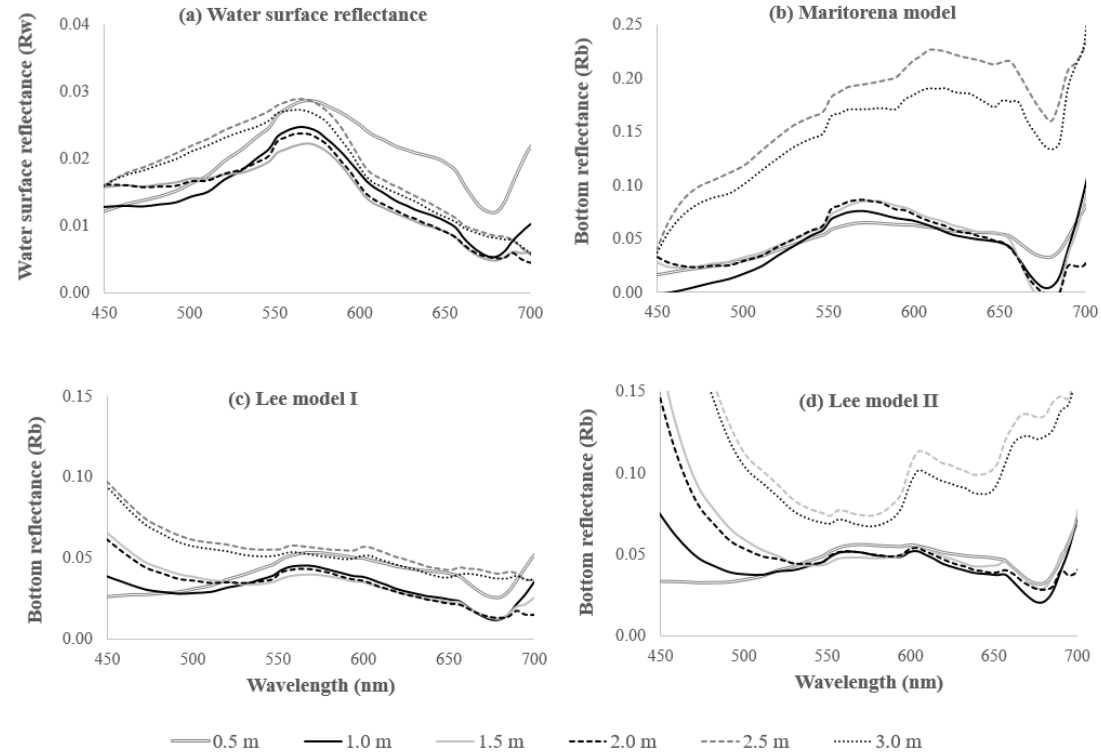
Figure 5. Dense vegetation (%SAV > 80%) reflectance spectra at various water depths before and after water column correction.